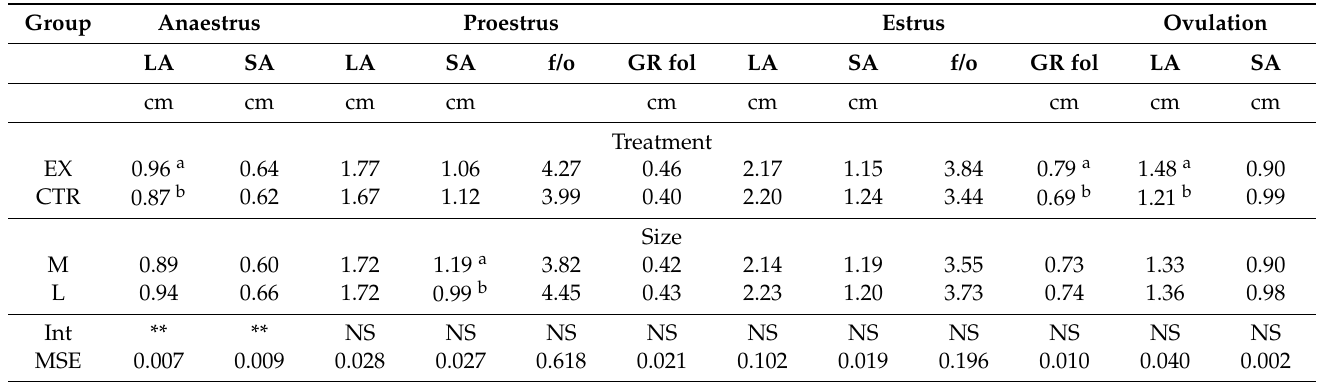
Table 2. Ultrasound data.